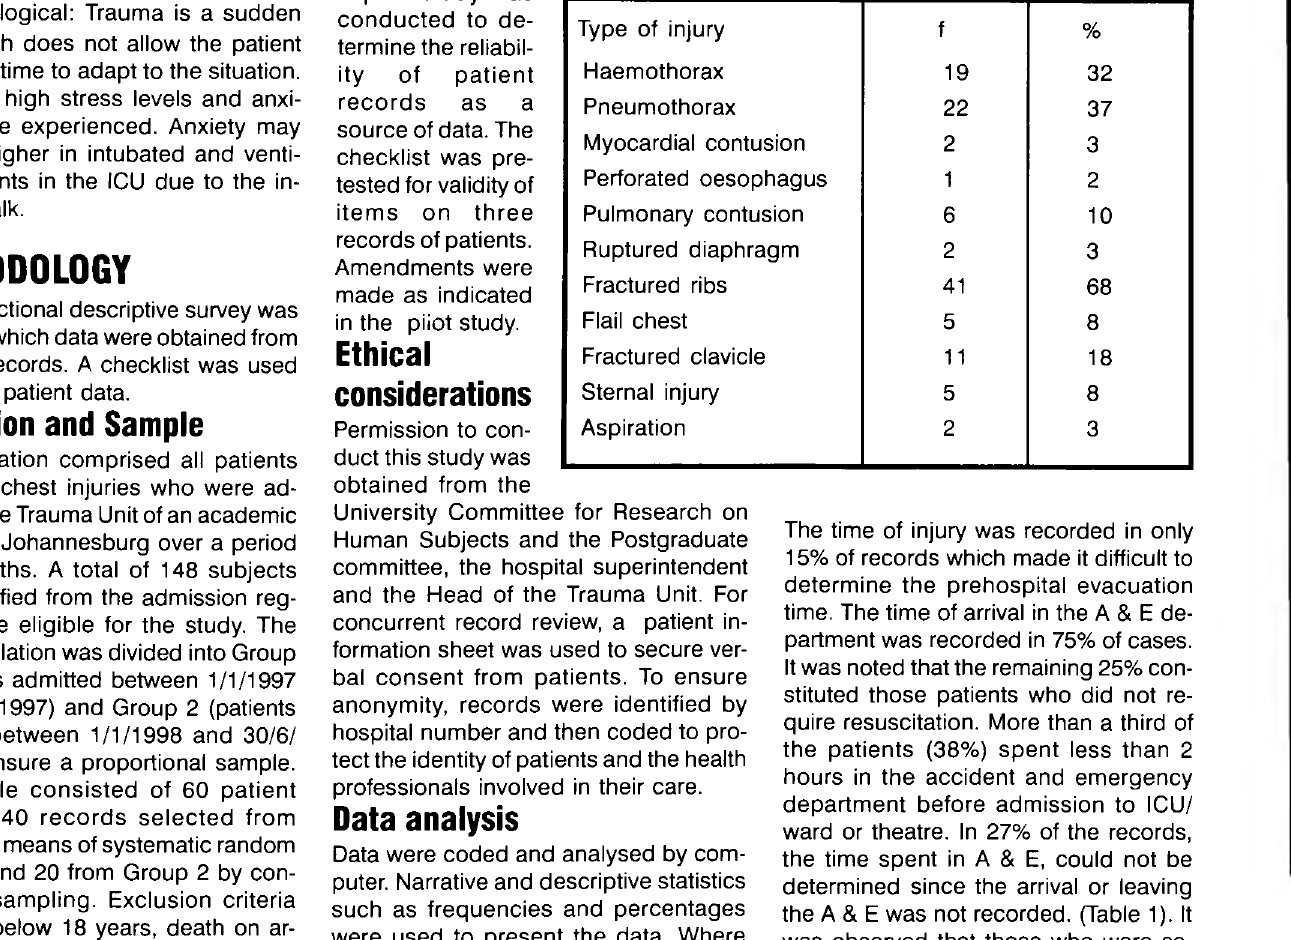
Table 2: Specific chest injuries